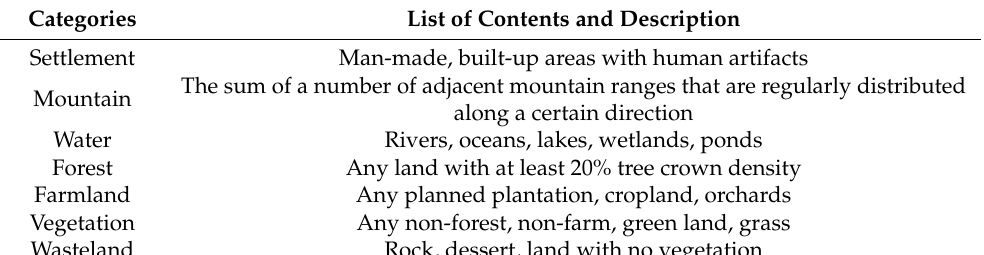
Table 2. Definitions of seven segmentation categories.